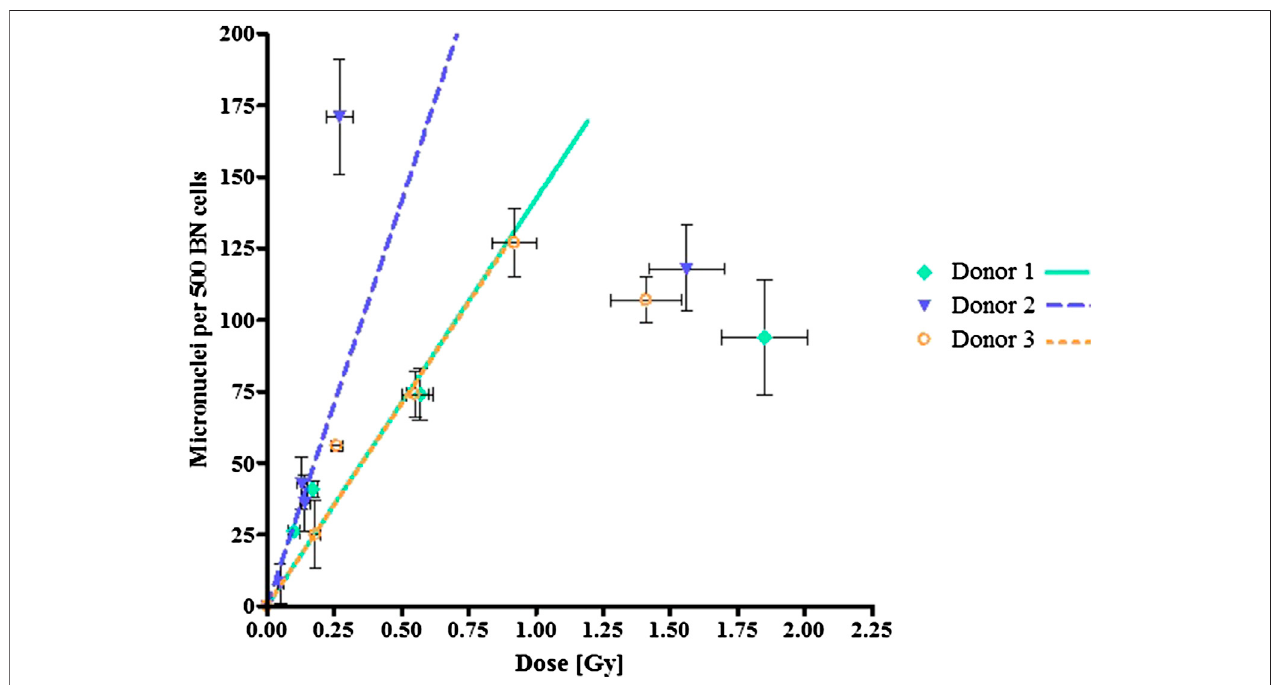
FIGURE 3 | Dose-response curves following exposure to 123IUdR activities presenting micronuclei formation as a function of absorbed radiation dose (Gy). The error bars are the standard deviations of the mean micronuclei frequency/500 BN cells for each dose point.